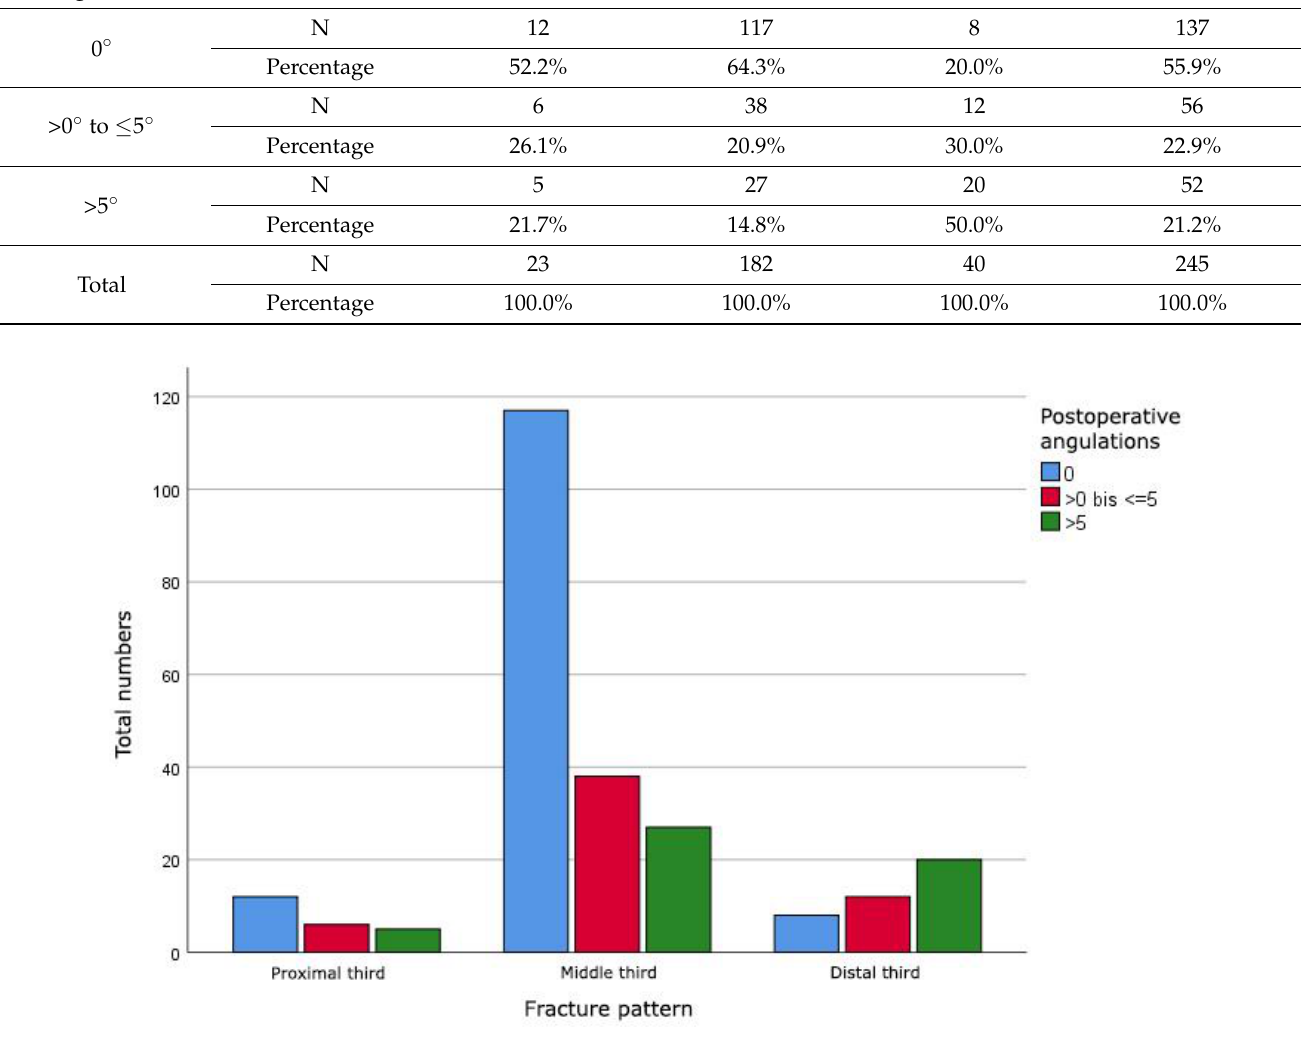
Figure 3. Comparison of fracture pattern and maximal postoperative angulations of diaphyseal radial fractures in degrees in both planes.